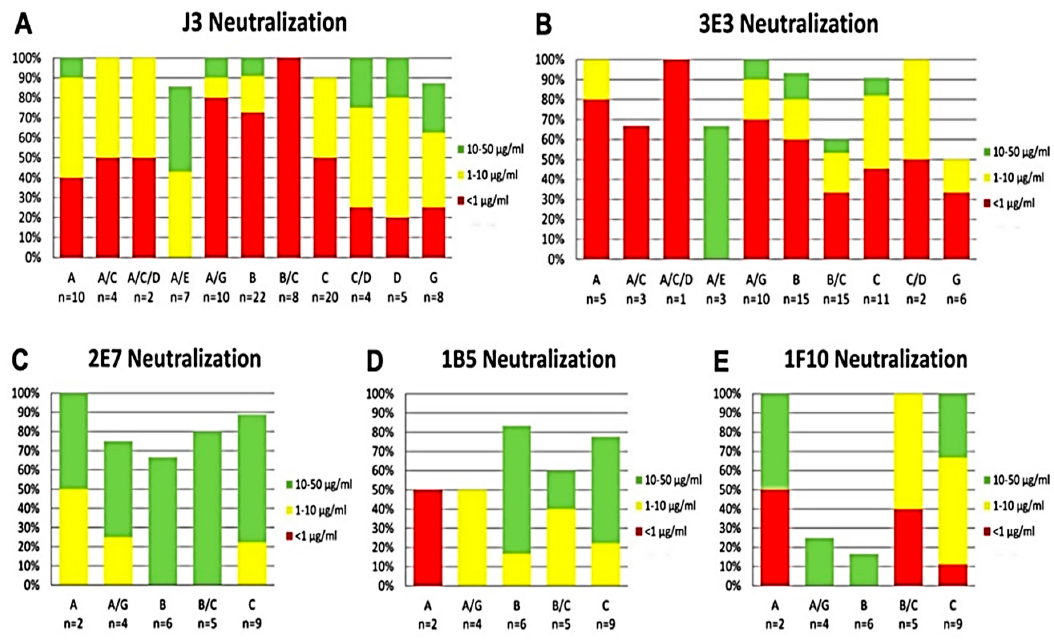
Figure 1. Clade Specific Neutralization of VHH. ( A ) J3, ( B ) 3E3, ( C ) 2E7, ( D ) 1B5 and ( E ) 1F10. The total neutralization per clade is shown by the height of the bar in the graph and the neutralization potency by the colors of the bar. Red indicates an IC50 < 1 µg/mL, yellow between 1 and 10 µg/mL and green between 10 and 50 µg/mL.